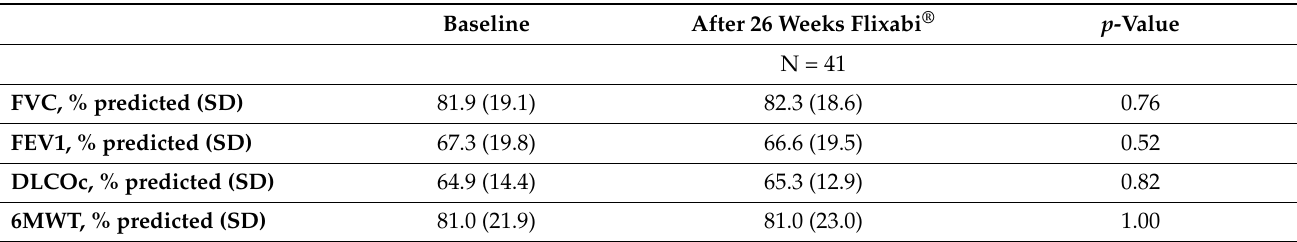
Table 4. Pulmonary function at baseline and 26 weeks after switching to Flixabi ® for patients with a pulmonary treatment indication; Mean